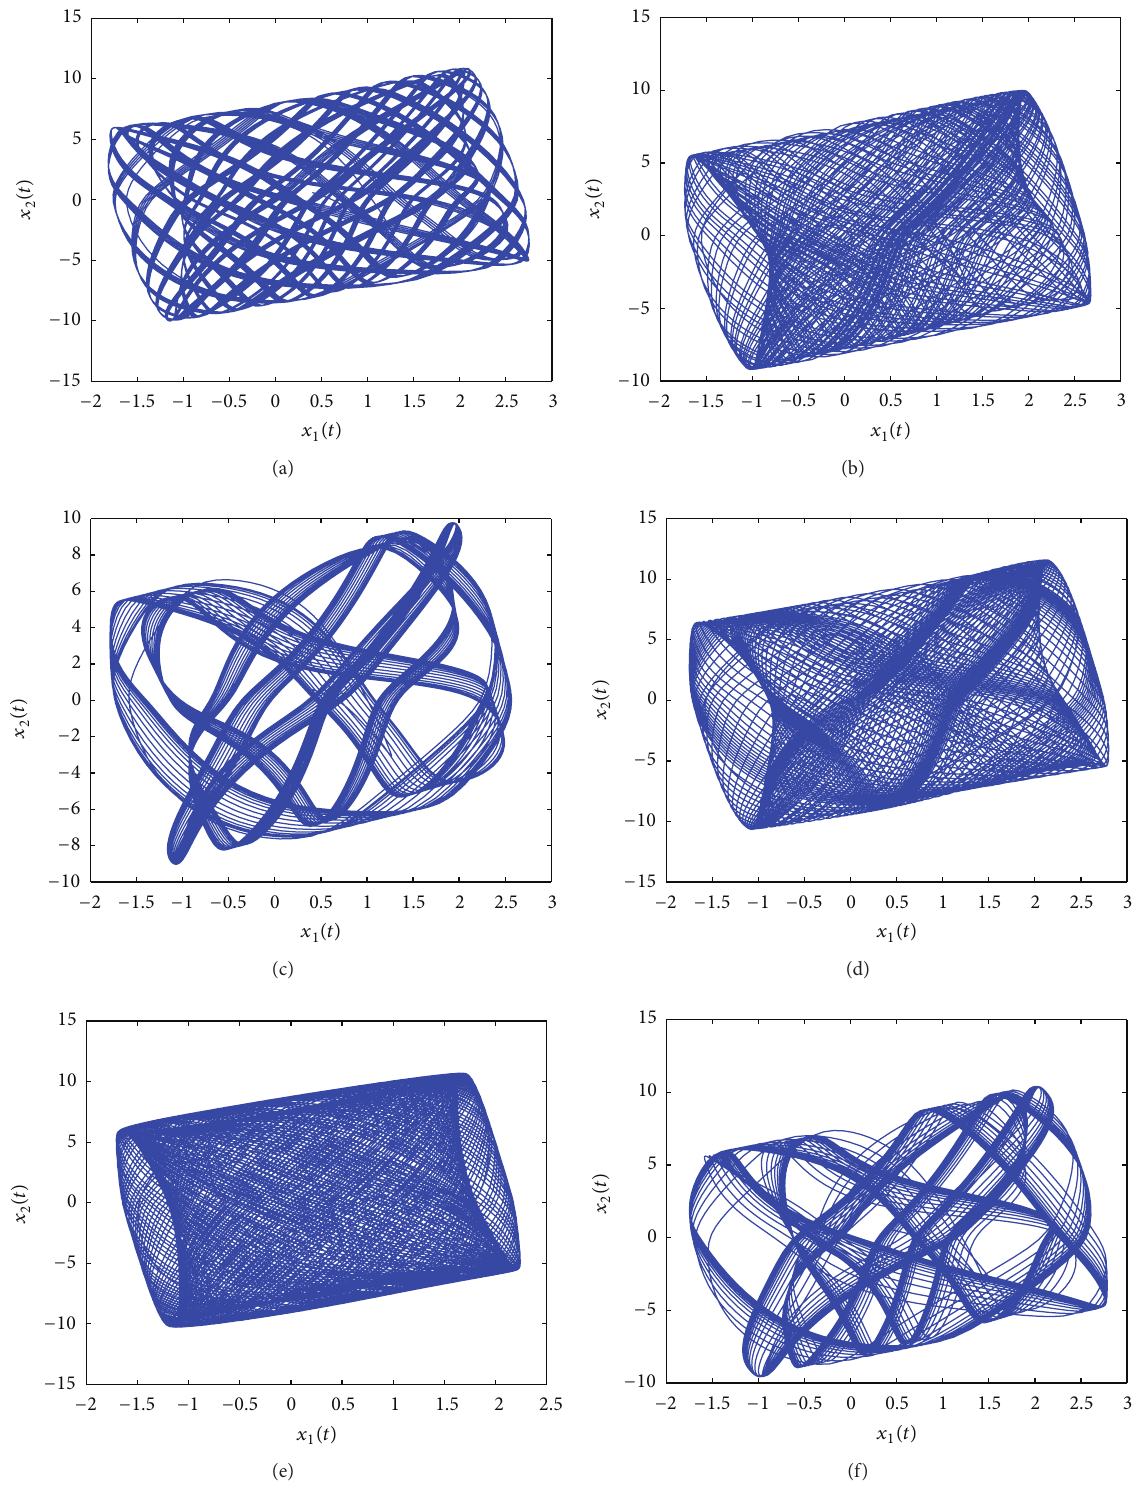
Figure 5: Trajectories of system (8) with different 𝑎, 𝑏, and 𝑐 : (a) 𝑎 = 0.2 , 𝑏 = 0.3 , and 𝑐 = 0.3 ; (b) 𝑎 = 0.2 , 𝑏 = 0.1 , and 𝑐 = 0.3 ; (c) 𝑎 = 0.2 , 𝑏 = 0 , and 𝑐 = 0.5 ; (d) 𝑎 = 0.2 , 𝑏 = 0.5 , and 𝑐 = 0 ; (e) 𝑎 = 1 , 𝑏 = 1 , and 𝑐 = 1 ; (f) 𝑎 = 0.1 , 𝑏 = 0.1 , and 𝑐 = 0.1